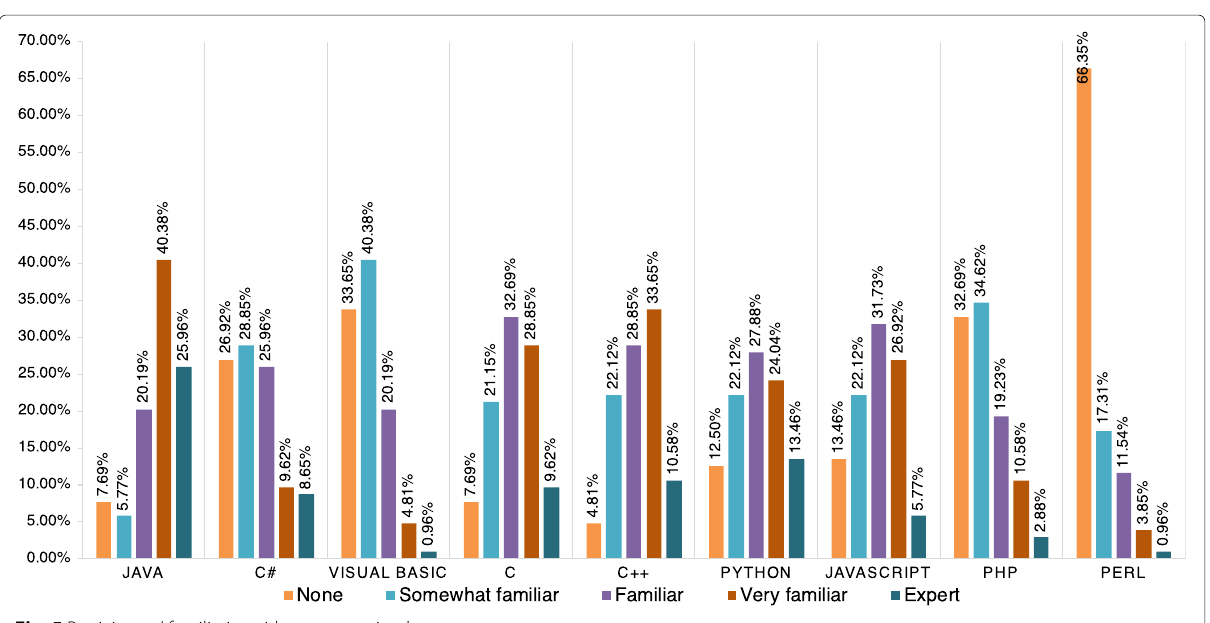
to vulnerability detection. 87 of the participants (87%) intimated that they would appreciate a system that can scan their code for vulnerabilities as they code; 10 (10%) were not interested in the technology, but believe other programmers may be interested; 3 participants did not believe it would be a good idea to apply IntelliSense to vulnerability detection, and 4 skipped the question.